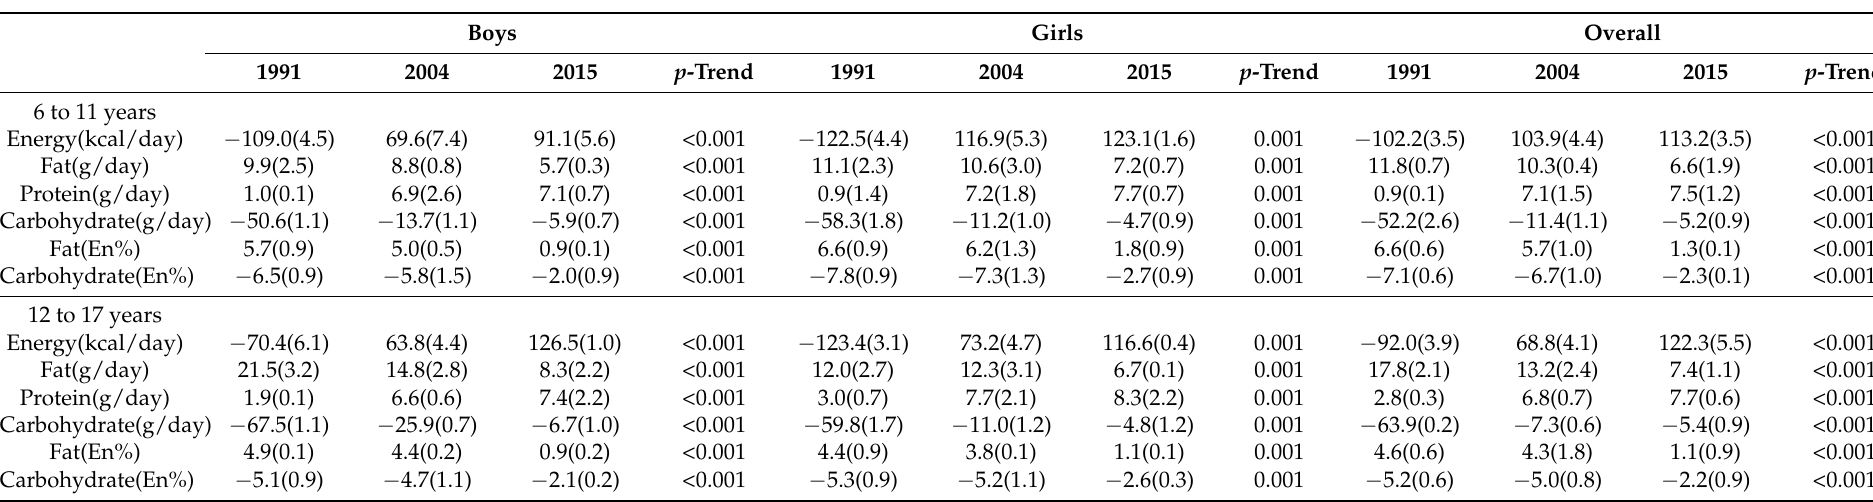
Table 4. Trends of the urban–rural disparities in the daily energy and macronutrient composition by gender and age group from CHNS round, 1991~2015 1–5 .